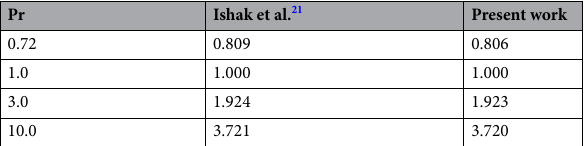
Table 2. Comparative analysis of Nusselt number for different values of Prandtl number when remaining parameters of temperature equation is zero.